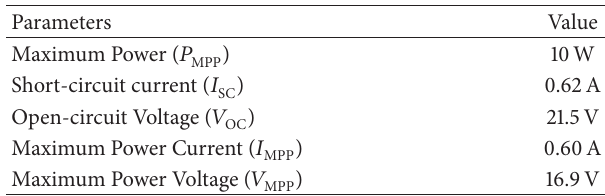
Table 4: KS10 specifications.